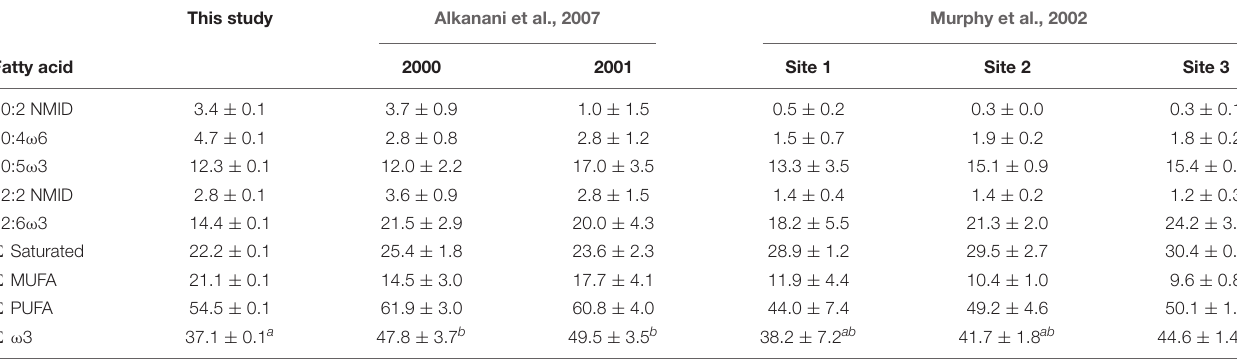
FIGURE 5 | Average seasonal (spring, summer, and fall) lipid and essential fatty acid content of Mytilus edulis from Saco Bay, ME, United States, collected between 2016 and 2017. (A) Concentration (mg g − 1 ) of total lipid, total fatty acid (FA), and essential fatty acids (20:5 ω 3, 22:6 ω 3 and 20:4 ω 6) (B) Proportion (%) of total lipid, non-methylene interrupted dienes (NMID), and essential fatty acids (20:5 ω 3, 22:6 ω 3, and 20:4 ω 6). Data shown are average ± standard error and statistically significant ( p < 0.05) differences across seasons are denoted by abc . TABLE 2 | Proportions (%) of fatty acids in Mytilus edulis measured in this study compared to literature values. This study Alkanani et al., 2007 Murphy et al.,